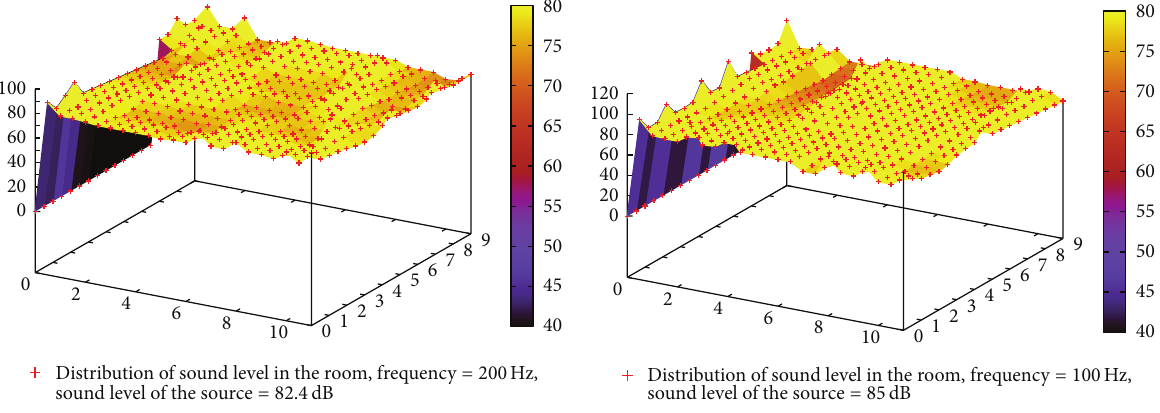
Figure 2: Noise map of the conference room in 100Hz (a) and 200 Hz (b).